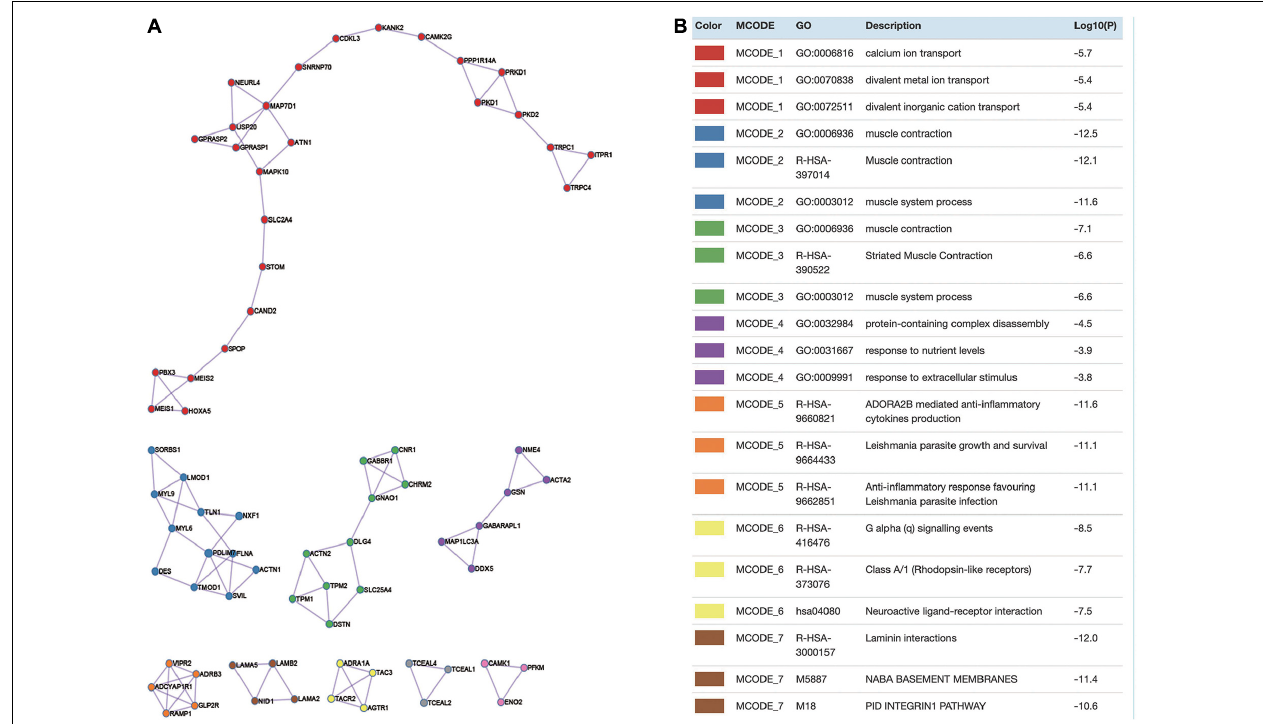
FIGURE 3 | Module analysis. (A) Identify hub genes from the protein–protein interaction (PPI) network using MCODE algorithm. Each color denotes a cluster detected by MCODE. (B) GO enriched by DEGs in different modules.